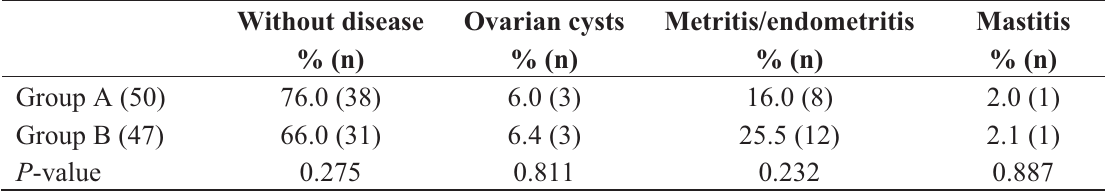
Table 5. Incidence (%) of ovarian cysts, metritis/endometritis and mastitis during the puerperium (until 42 d post partum ) in Group A and Group